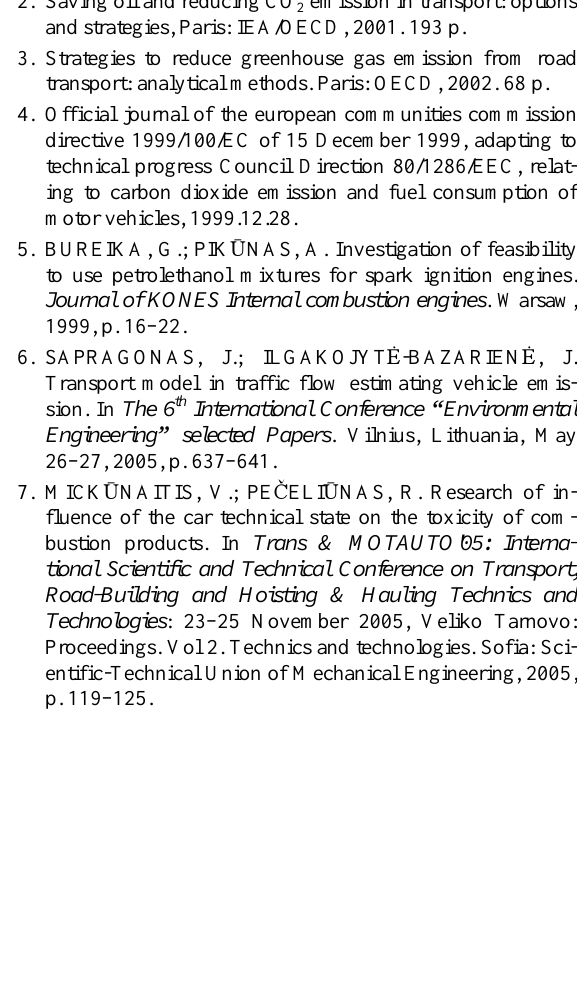
The data presented show that fuel consumption and CO emission of full-size automobiles (using petrol or die- 2 sel oil) is twice as much as that of compact